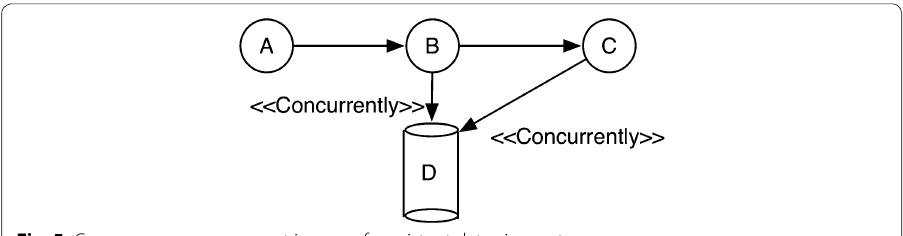
Fig. 4 The cycle-in anti-pattern